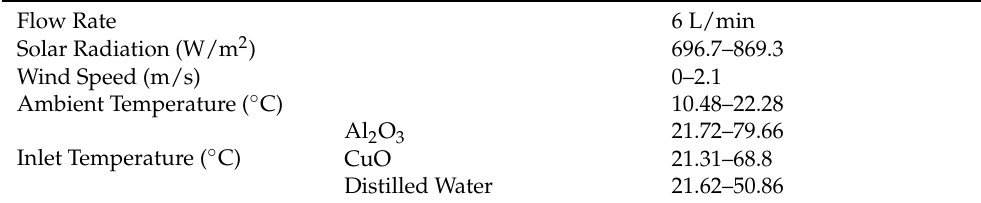
Table 4. The experimental conditions and when the flow rate is 6 L/min.